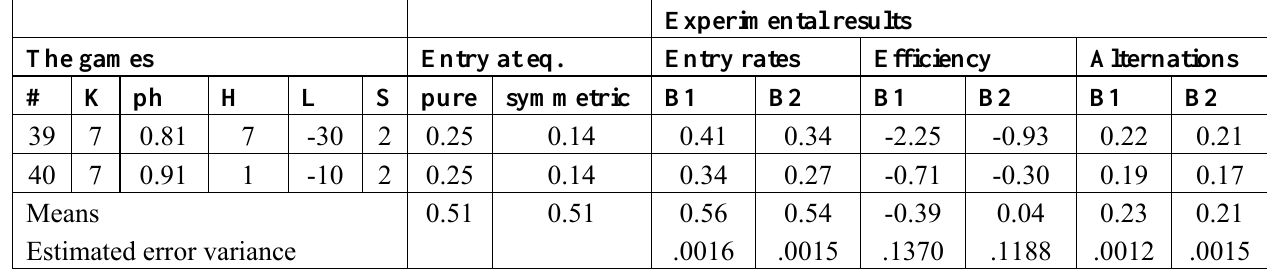
Table 2. Cont. Experimental results